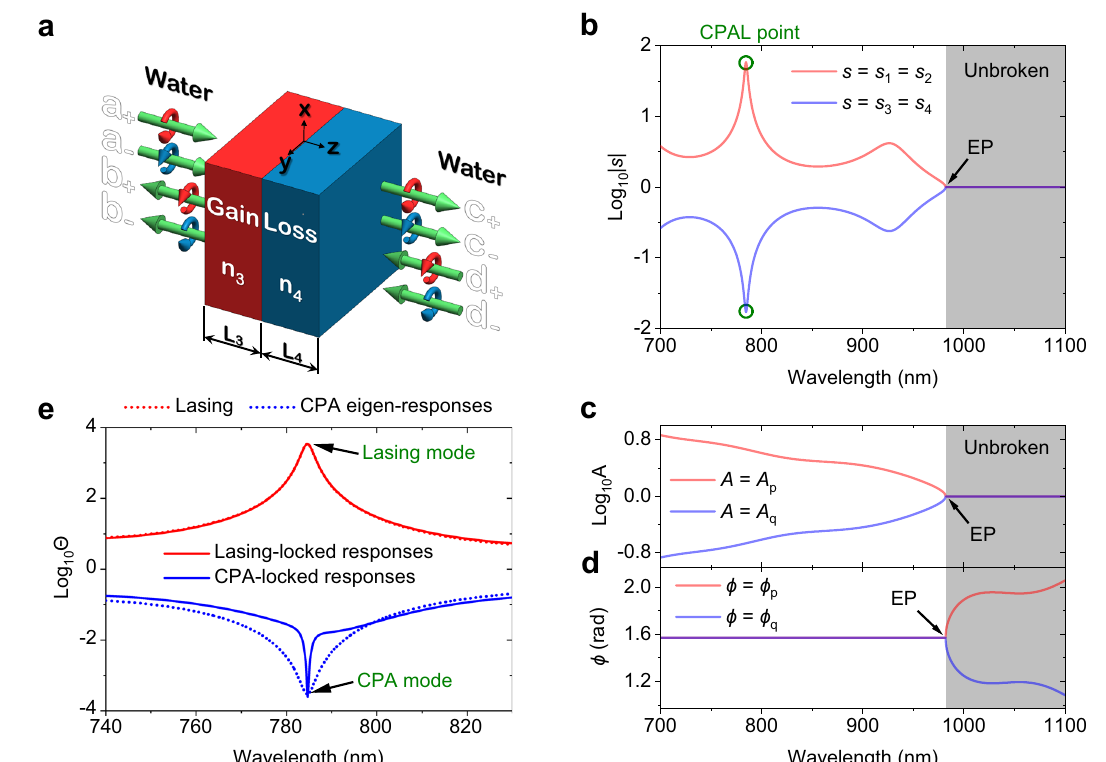
Fig. 1 Eigen characteristics of PT -symmetric system S PT . a PT -symmetric system composed of two homogeneous isotropic gain and loss slabs of equal length ( L 3 = L 4 = L ) with refractive indices n 3 = 2.1 − 0.207 i and n 4 = 2.1 + 0.207 i is characterized by a scattering matrix S PT in circular polarization representation. a , d and b , c represent the complex electric- fi eld amplitudes of normally incident and scattered circularly-polarized (CP) waves propagating along the z axis, respectively. The + ( − ) sign in the subscript indicates left- and (right-) handed CP [LCP and (RCP)] states, respectively. The geometry is in fi nite in the x and y directions with water as a background medium ( n 1 = n 6 = 1.33). b Semi-log plot of the modulus of the eigenvalues of S PT as a function of wavelength λ . Green circles denote the coherent perfect absorber-laser (CPAL) point and exceptional point (EP) separates two distinct PT phases. c , d Semi-log plot of the relative amplitude A and phase ϕ of the two counter-propagating oppositely handed CP incident waves of the same wavelength, extracted from the eigenstates of S PT , as a function of λ . e Semi-log plot of the output coef fi cient Θ as a function of λ for the lasing-locked, CPA-locked, and eigen S PT systems. CPA is an acronym for coherent perfect